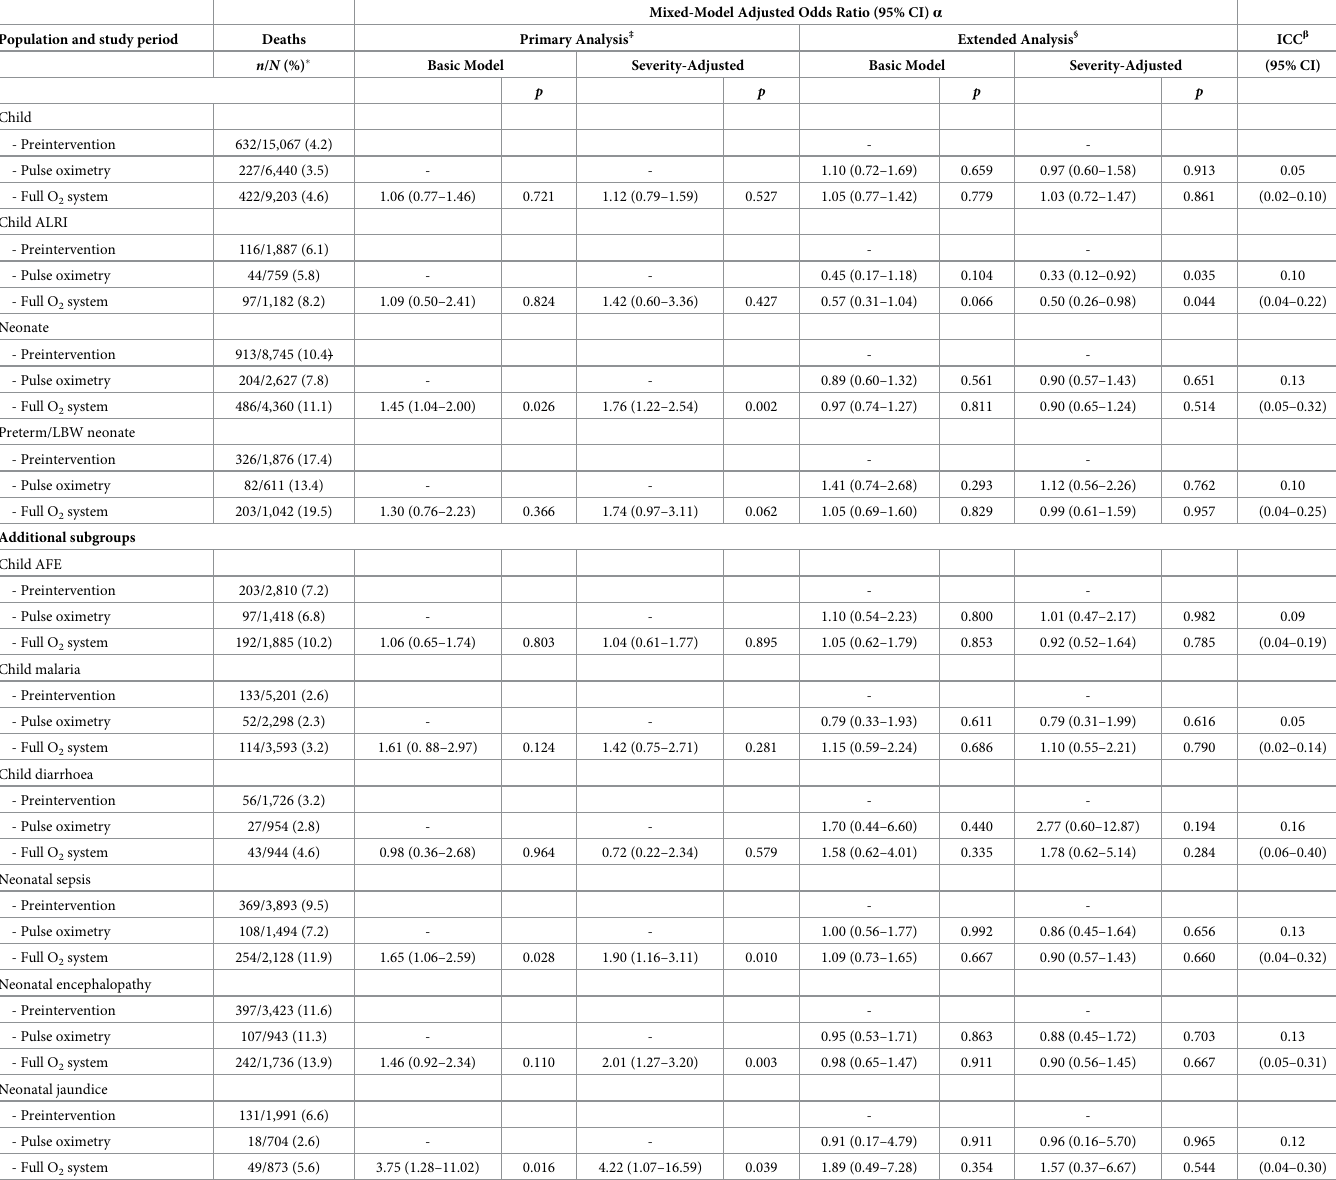
Table 3. Effect of the intervention(s) on mortality, showing the primary analysis (full oxygen period versus pulse oximetry period) and extended analysis (compar- ing pulse oximetry and full oxygen system periods to the preintervention period). Mixed-ModelAdjustedOddsRatio(95%CI) α Populationandstudyperiod